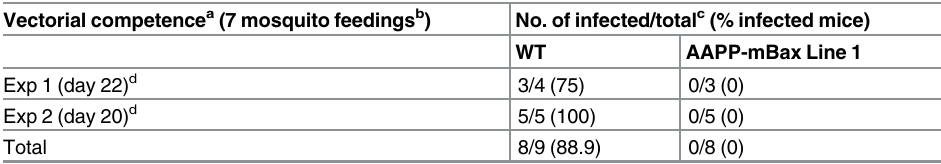
Table 2. Blockade of P . berghei transmission in transgenic